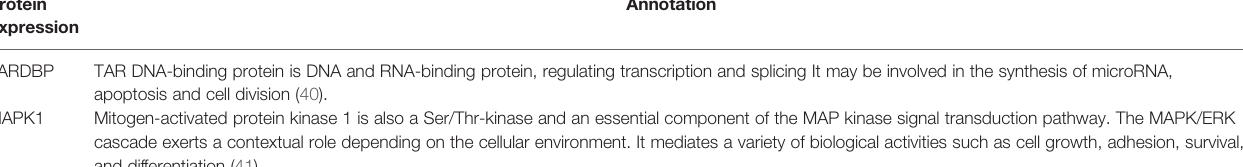
TABLE 2 | Annotations of proteins to which progesterone have a high af fi nity. Protein Expression